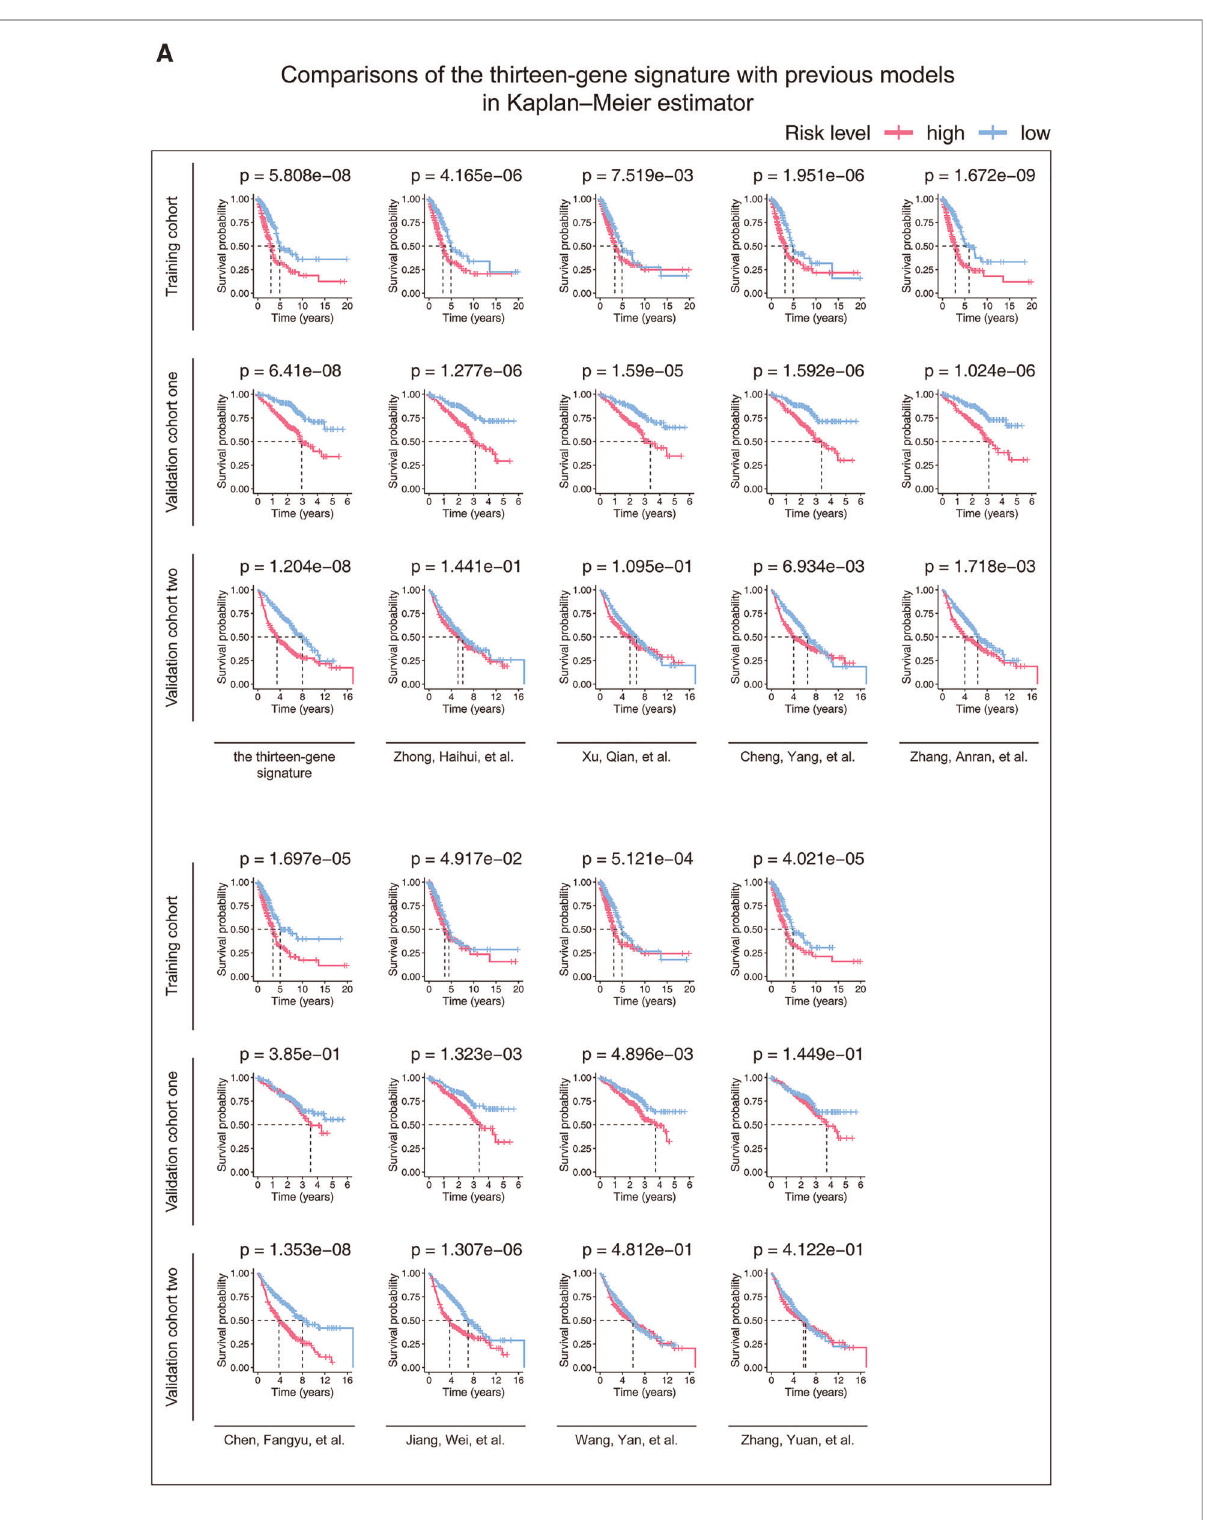
FIGURE 4 Kaplan-Meier analysis ( A ) and Cox models ( B ) were performed in the studied cohorts to compare our and previous studies ’ predictive abilities. ( A ) Patients in each cohort were divided into low-risk groups and high-risk groups based on their median risk score. The log-rank test with a p -value<0.05 suggests the survival difference is signi fi cant. ( B ) Only univariate variables with p -values less than 0.1 were included in the multivariable analysis. The bold words mean the p -value<0.05. P -value is considered signi fi cantly. HR, hazard ratio; CI, con fi dence interval; PMID, PubMed ID,